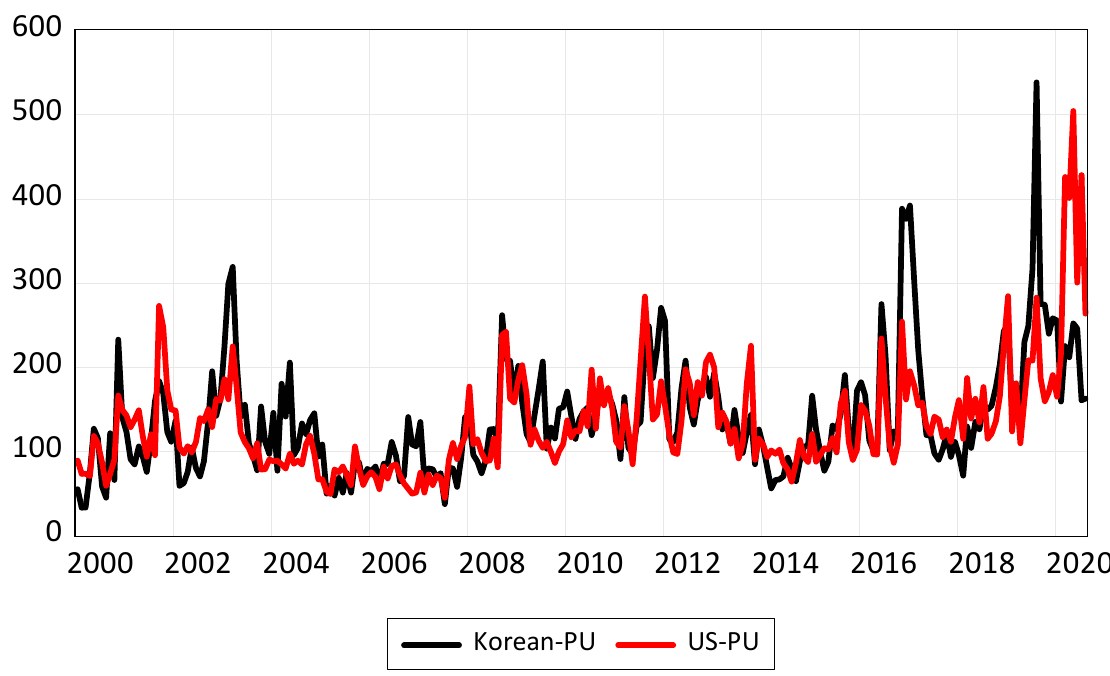
Figure 1. Monthly economic policy uncertainty indices.